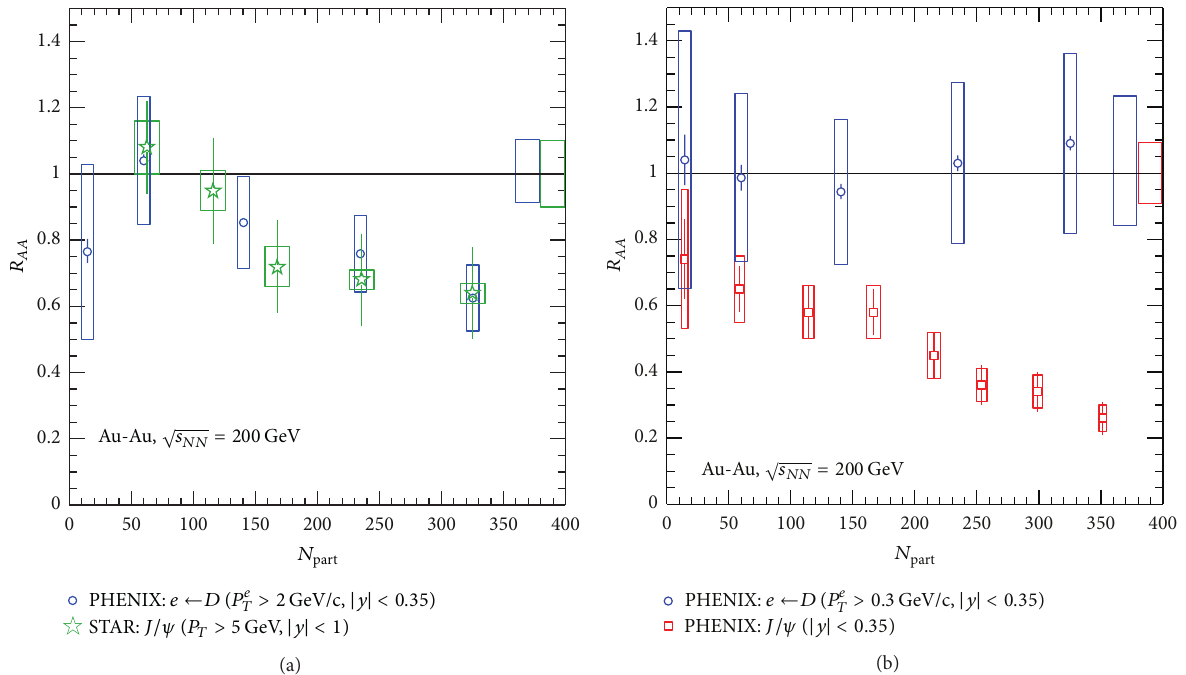
Figure 5: RHIC data from PHENIX and STAR [30–33], comparing 𝐽/𝜓 production to open charm production at high (a) and low (b) transverse momenta.